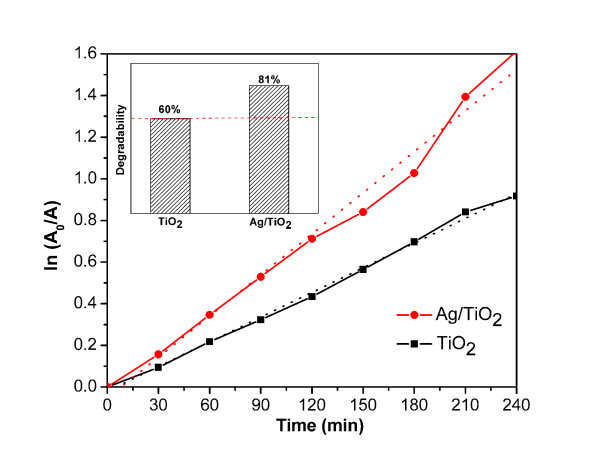
Performances of Ag/TiO2nanocomposite film and TiO2film for photocatalytic degradation of MB under UV light irradiation.